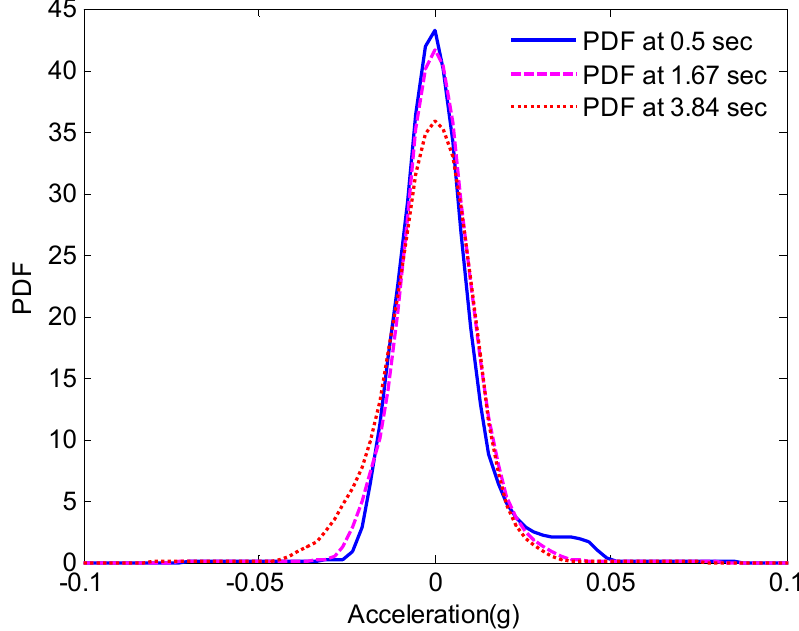
Figure 5. PDF of the acceleration response of the superstructure.